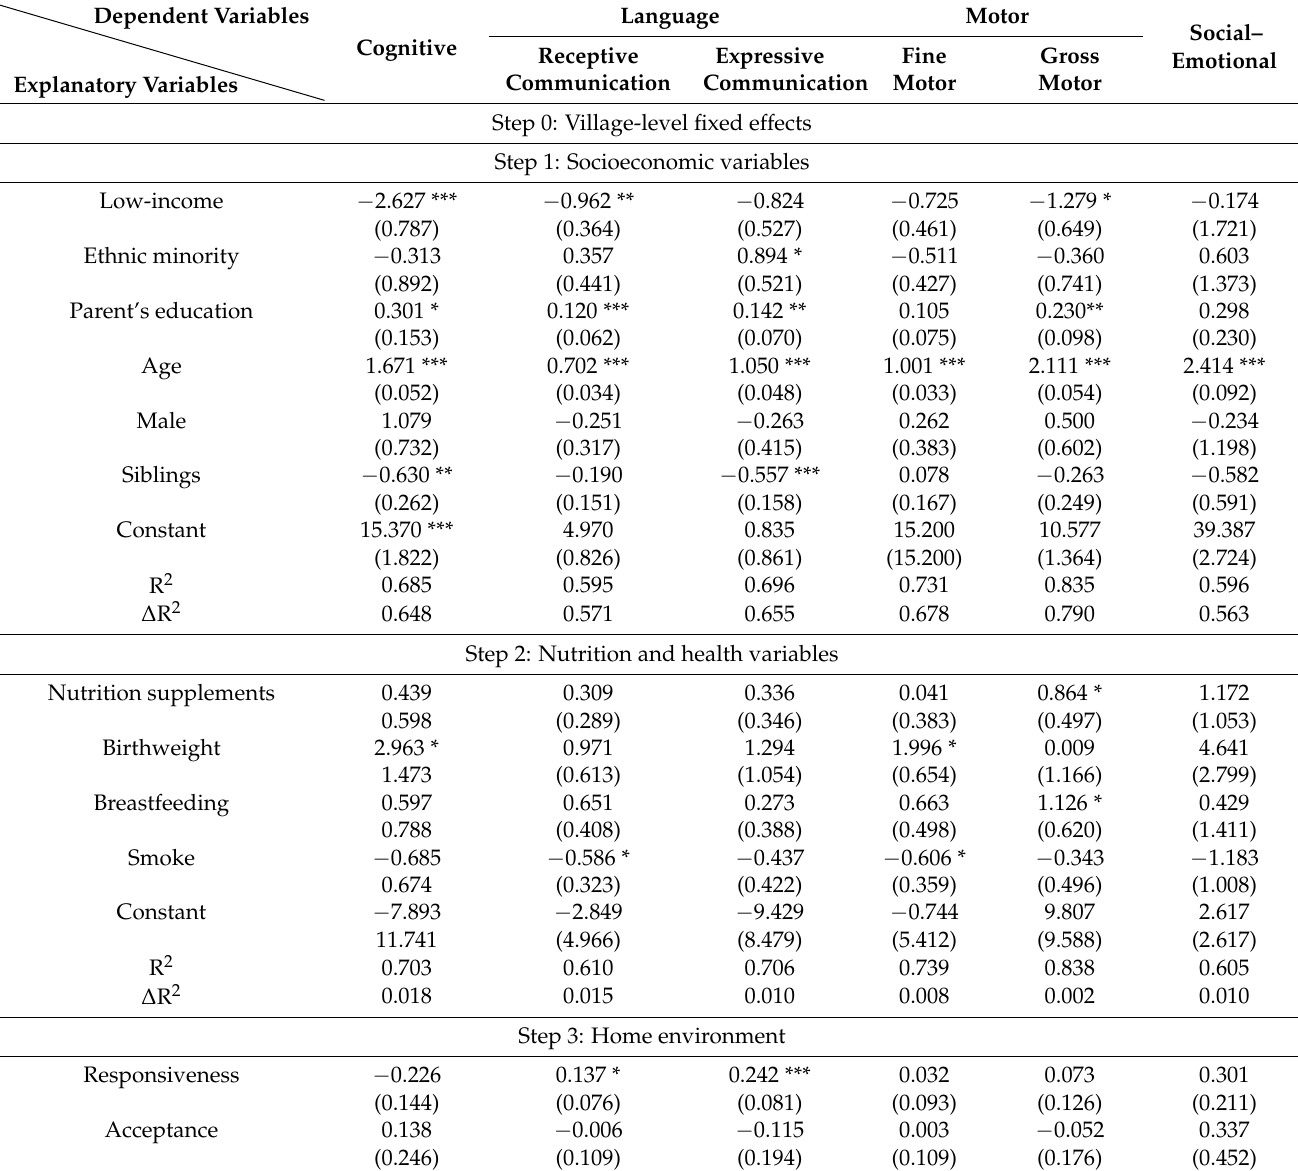
Table 7. Hierarchical regression results (stage 3 with detailed HOME